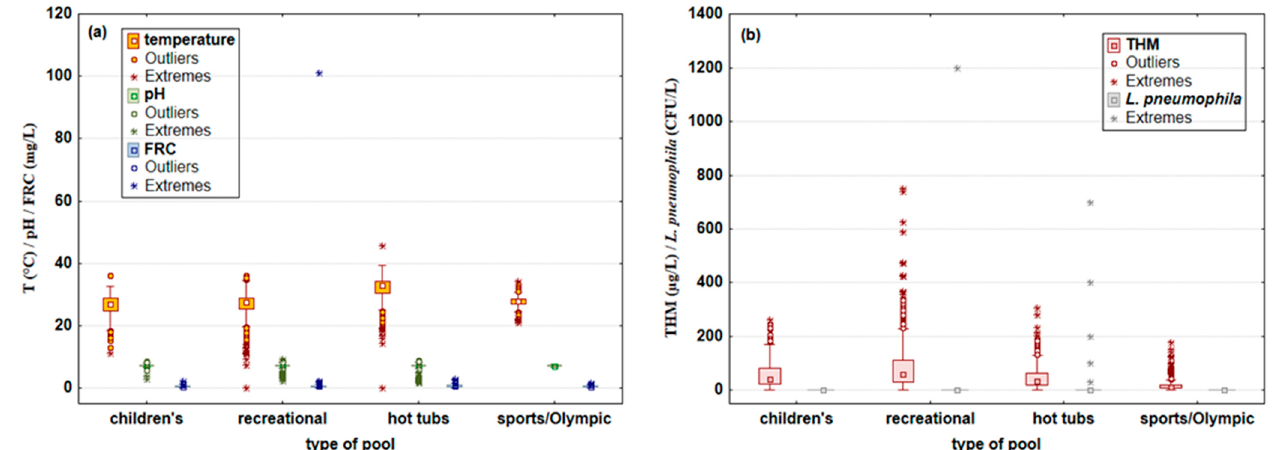
Figure 2. Water physicochemical parameters: ( a ) temperature (°C), pH, and free residual chlorine (FRC; mg/L), and ( b ) trihalomethanes (THM; μ g/L) and amount of Legionella pneumophila (CFU/L) in children´s, recreational, hot tubs, and sports/Olympic swimming pools. Results are shown as me- dian, minimum, and maximum values with outliers and extreme values (N pool data = 4587; N children´s data = 495; N recreational data = 2833; N hot tubs data = 966; N sport/Olympic data = 293).